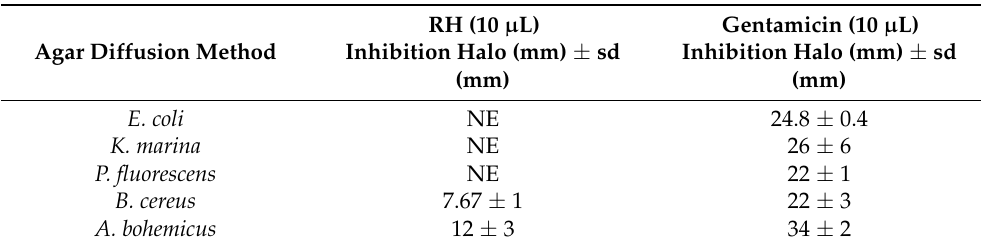
Table 3. Antibacterial activity of 10 µ L of pure RH and 10 µ L of Gentamicin (1 mg/mL) evaluated using the agar diffusion method. NE: No Effect.